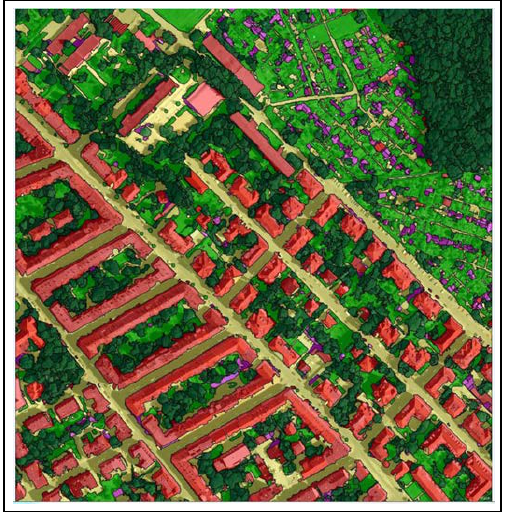
Figure 3. Classified image for a residential area in the City of Leipzig; see square in Fig. 2 for the zoomed-in location To distinguish the tree cover within the City of Leipzig, the two derived data sets undergo a GIS analysis in which the amount of tree cover is calculated for each urban district. In addition, the differentiation between trees and young trees / bushes is depicted for the year 2012 (Tab. 2).